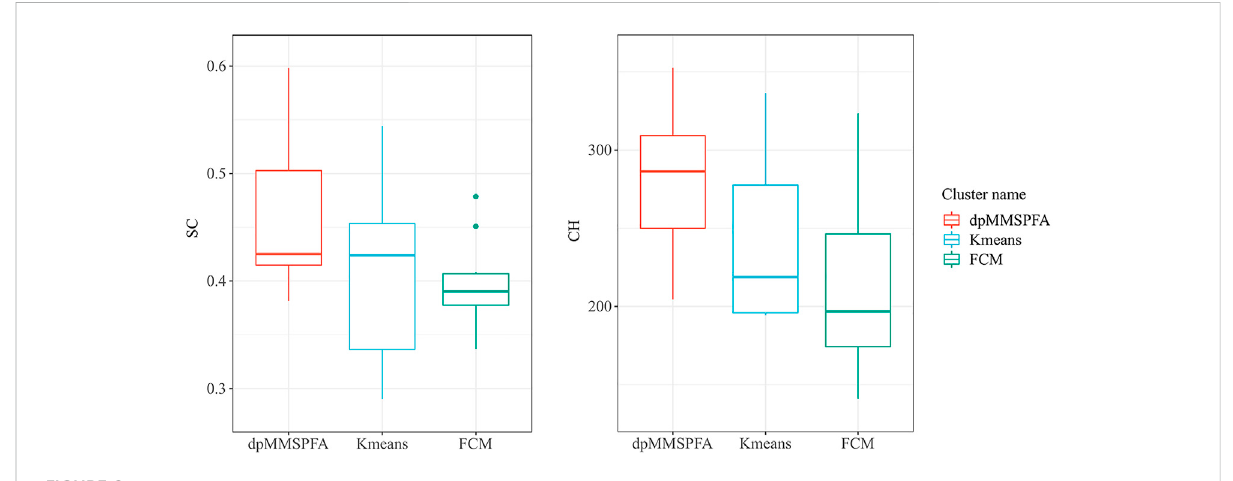
FIGURE 8 Boxplot of clustering effectiveness comparison.